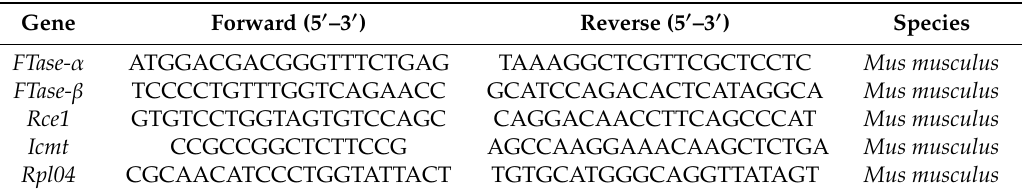
Table 2. List of primers used in the present